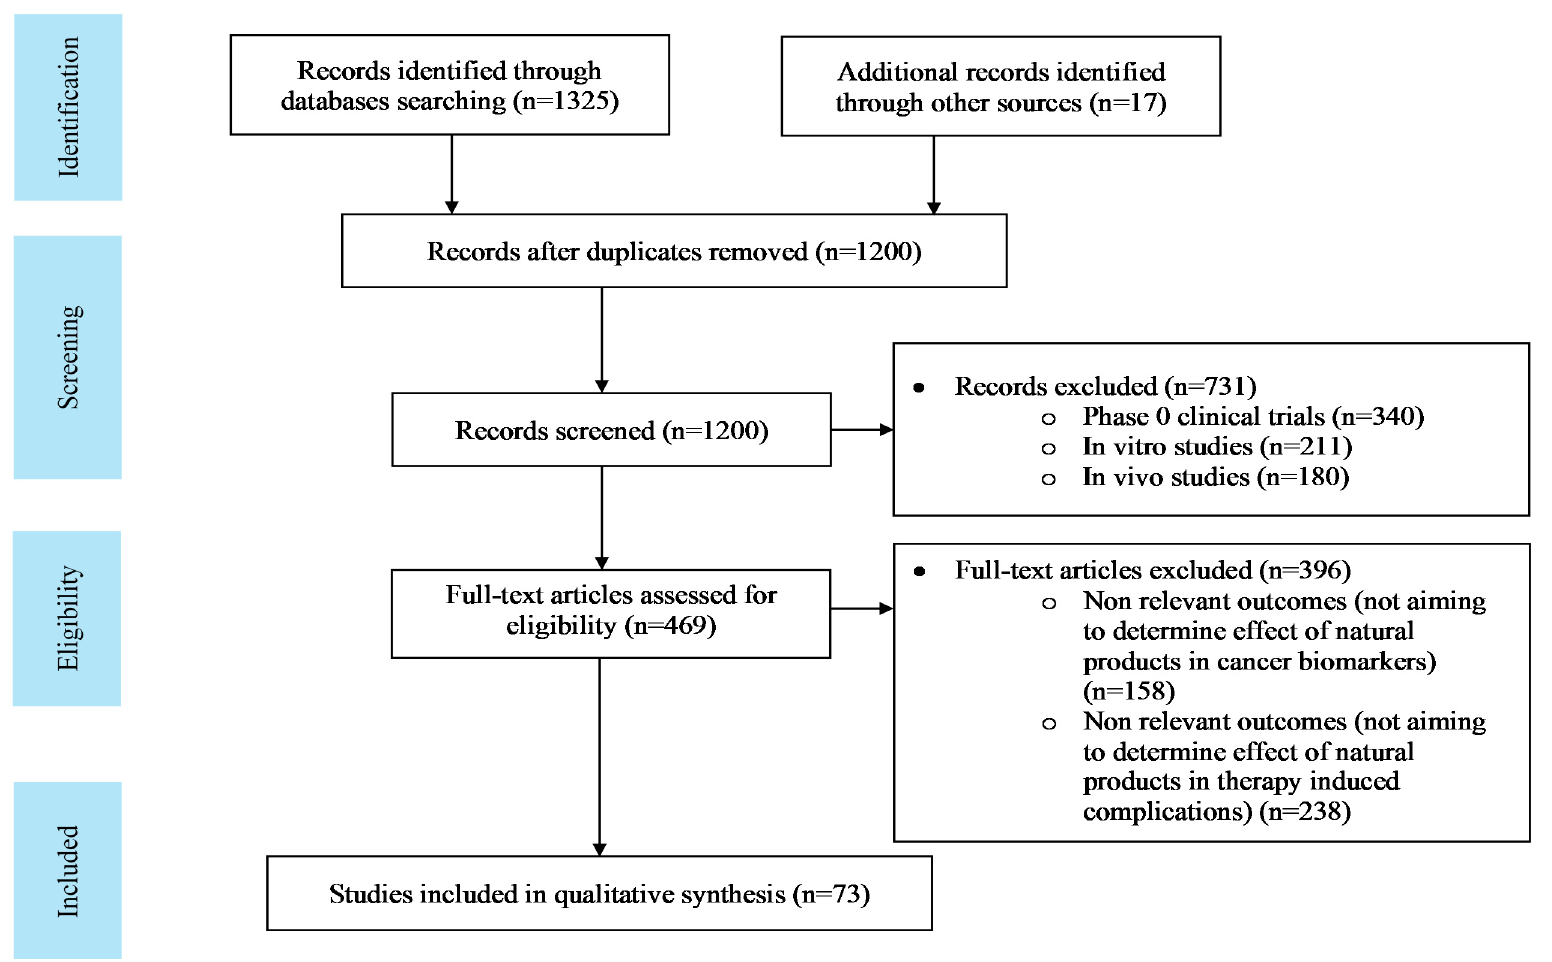
Figure 1. PRISMA (Preferred Reporting Items for Systematic Reviews and Meta-Analyses) flow sheet for literature search.